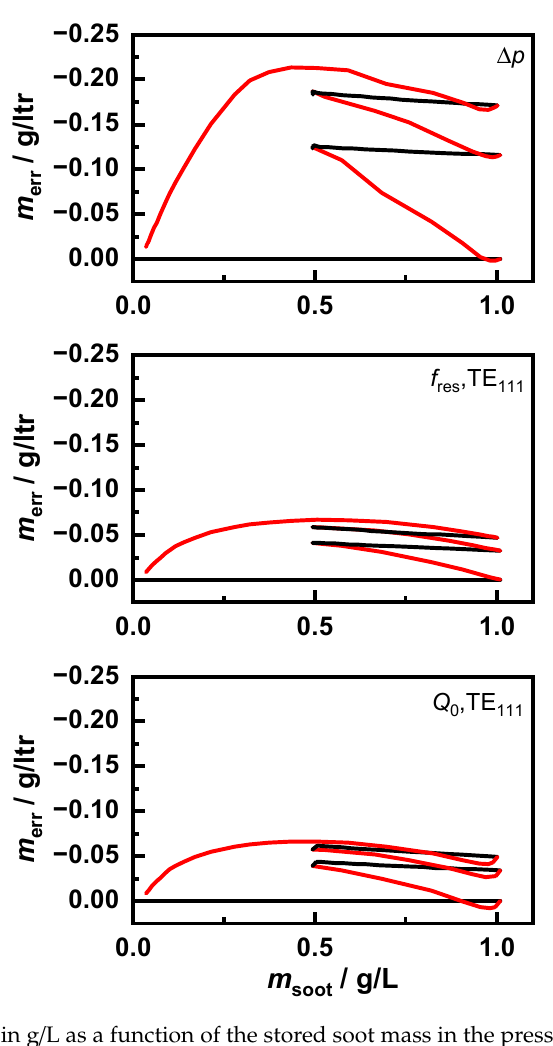
Figure 9. Sensor error in g/L as a function of the stored soot mass in the pressure differential sensor and the RF sensor based on f res relative to Q 0 . The regeneration phases are marked in red.